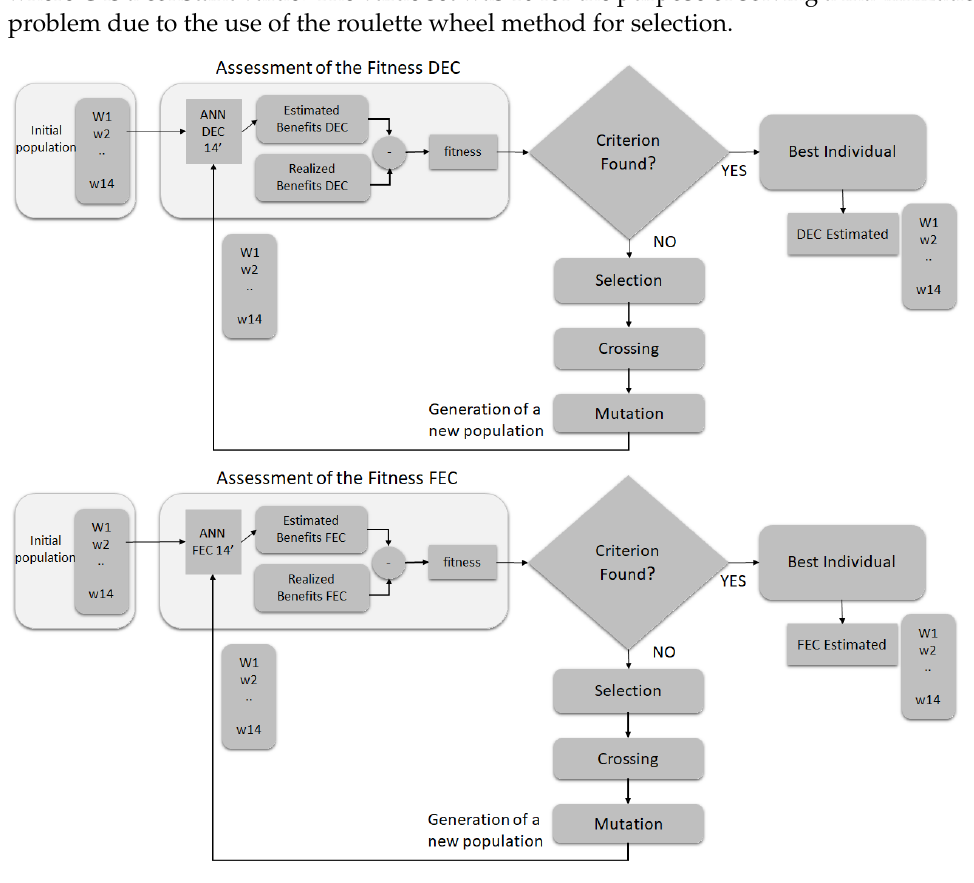
Figure 2. Population and generations of the evolutionary strategy. The estimated DEC and FEC values used in the fitness function are the results of the ANN output, where the input was the chromosome of the evolutionary strategy composed of the 14 multiplicative factors. All values generated by the output of each ANN according to each input are evaluated, and the individuals with the best fitness function